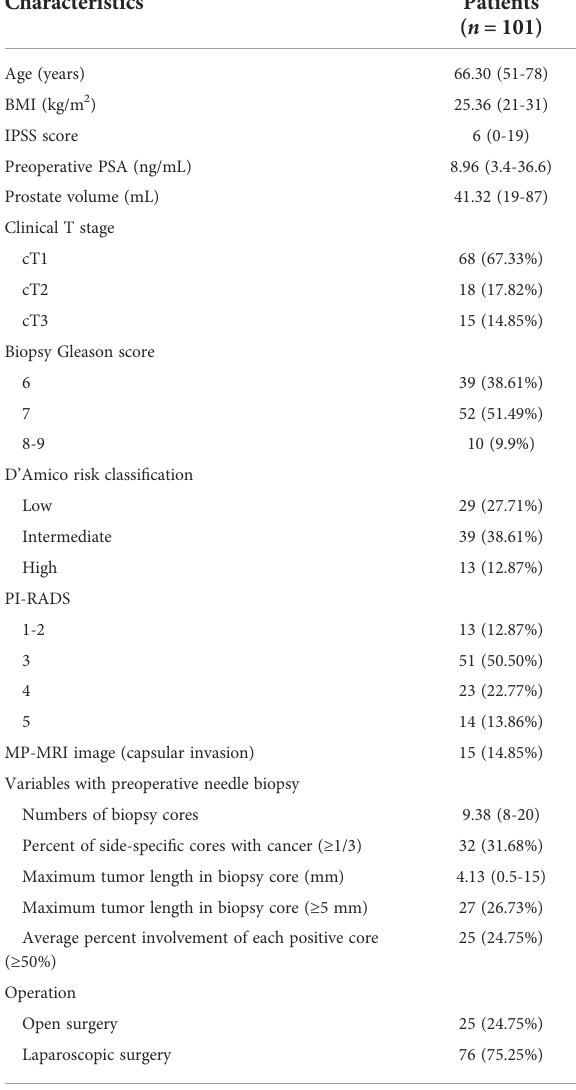
TABLE 1 Baseline characteristics of the study population.